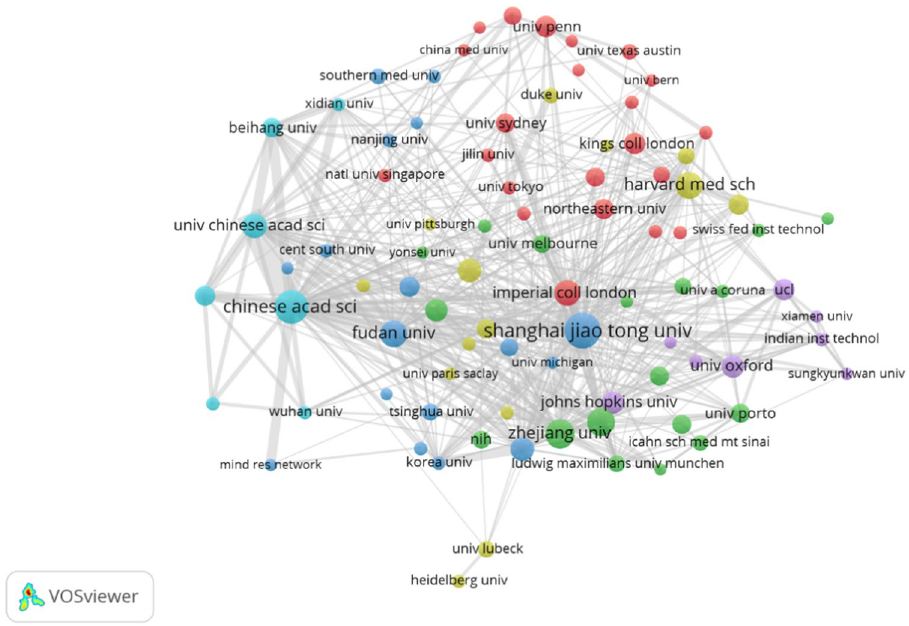
Fig. 13 Country bibliographic coupling network of MMDLM- related